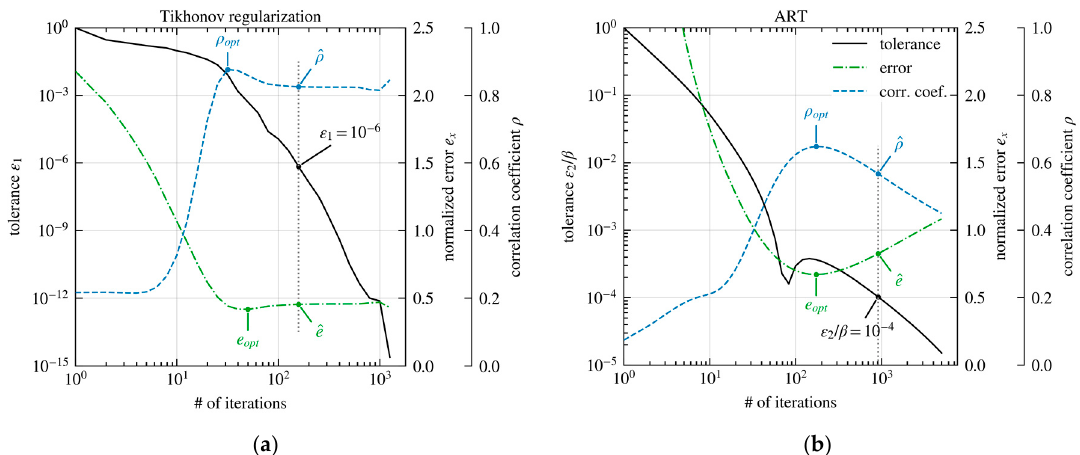
Figure 5. Convergence behavior of ( a ) Tikhonov regularization and ( b ) ART for turbulent species distributions (Figure 2) and a noise level of 20% as a function of the number of iterations. The respective convergence criterion (tolerance, black solid), the normalized error (green dash-dotted) and the correlation coefficient of two reconstructed distributions with statistically independent noise (blue dashed) are shown.